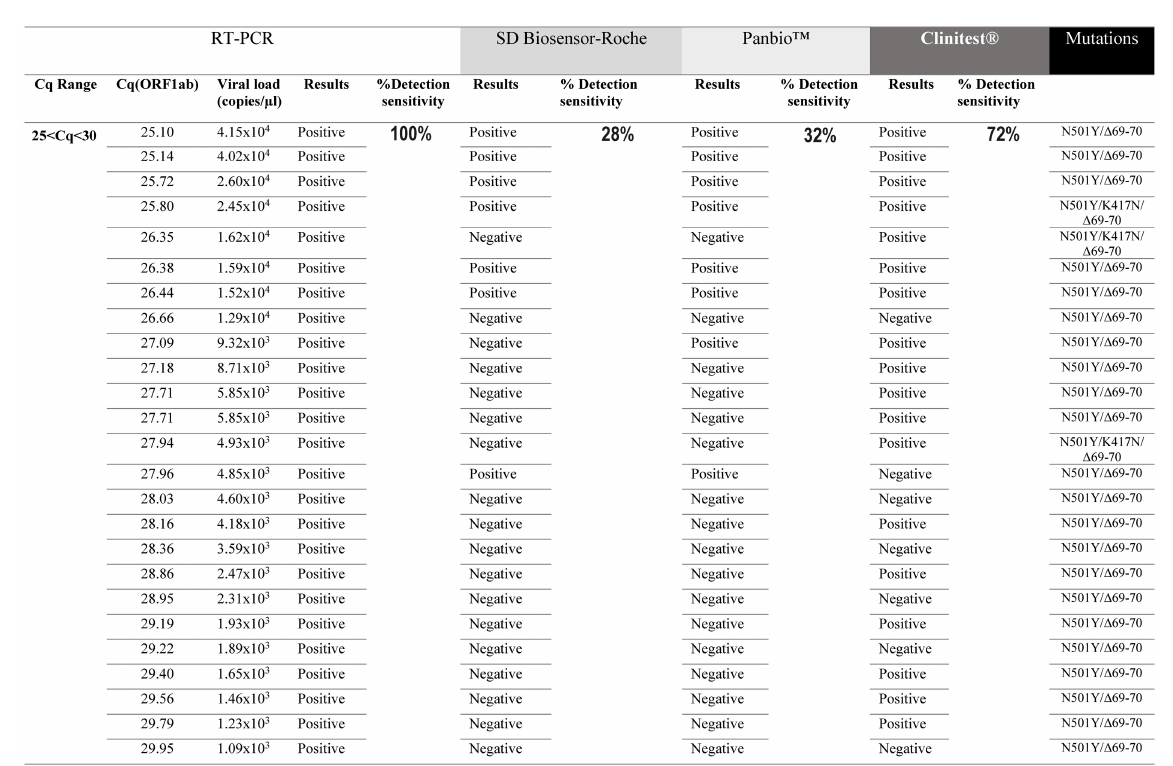
FIGURE2 Evaluation of the sensitivity for the rapid antigen test SD Biosensor-Roche, Panbio TM and Clinitest ® in detecting the Omicron variant at 25 ≤ Cq < 30 range. All samples were positive for RT-PCR (100%). A total of 25 samples were analyzed. The same NPSs were analyzed by all four methods (RT-PCR and three RATs). N501Y/ 1 69-70del and N501Y/K417N/ 1 69-70del mutations correspond to subvariants BA.1 and BA.4/5, respectively.